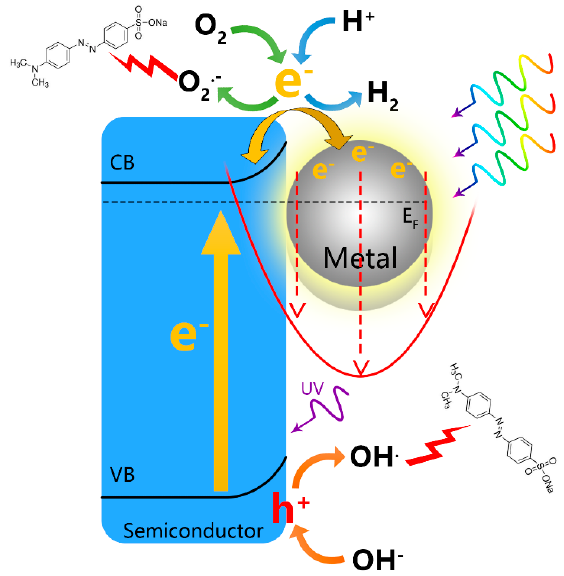
Figure 2. Illustration of plasmonic-mediated photocatalysis. CB, conduction band.